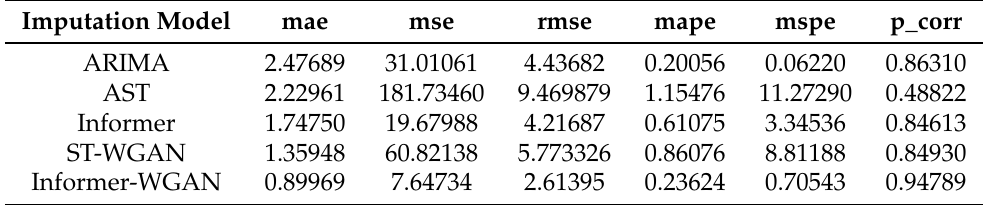
Table 4. The imputation results of different models on electricity dataset at a missing rate of 60%. Imputation